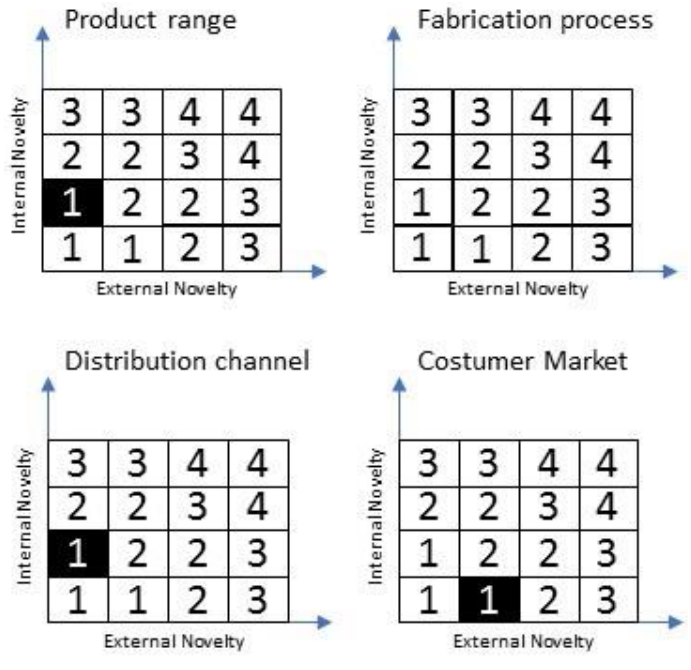
Figure 4. Characterization of project A.